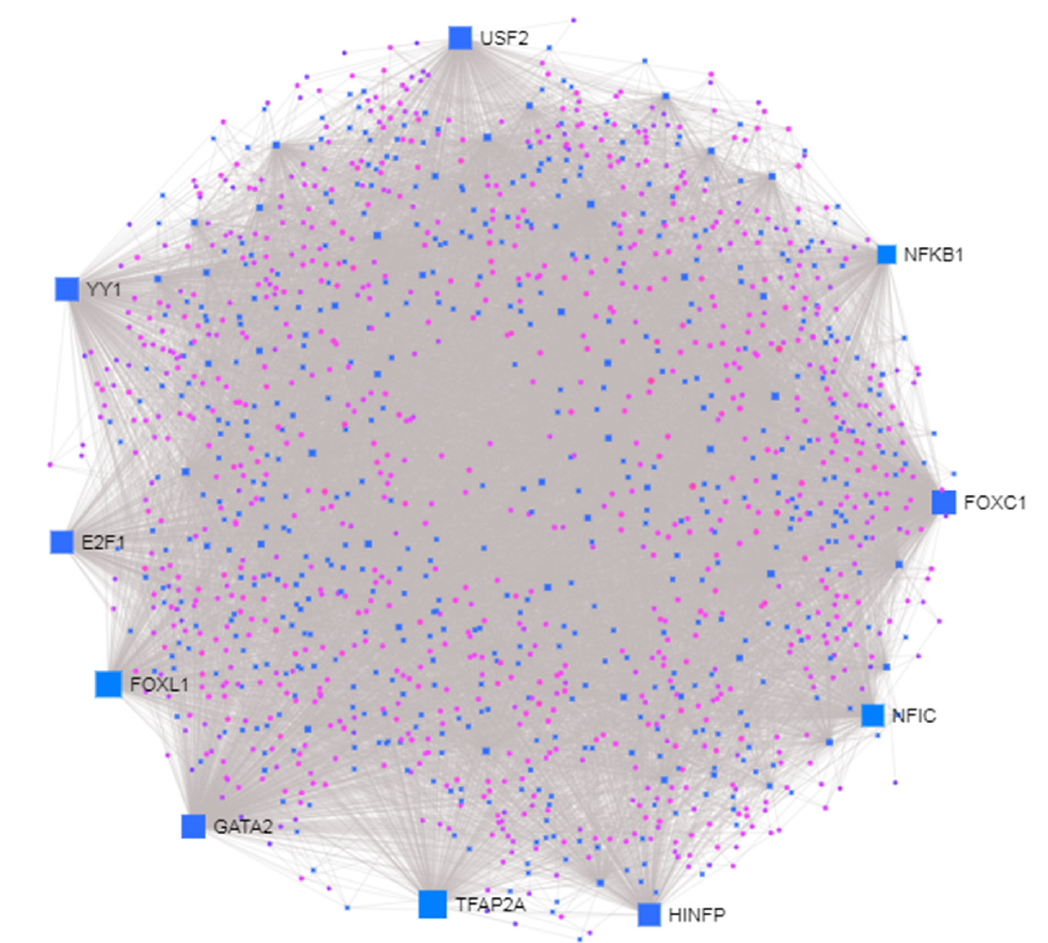
Figure 5. Network constructions of differentially expressed genes and transcription factors. Pink indicates genes and blue squares represent transcription factor. The larger blue squares show the hub transcription factor. The grey lines represent interaction.